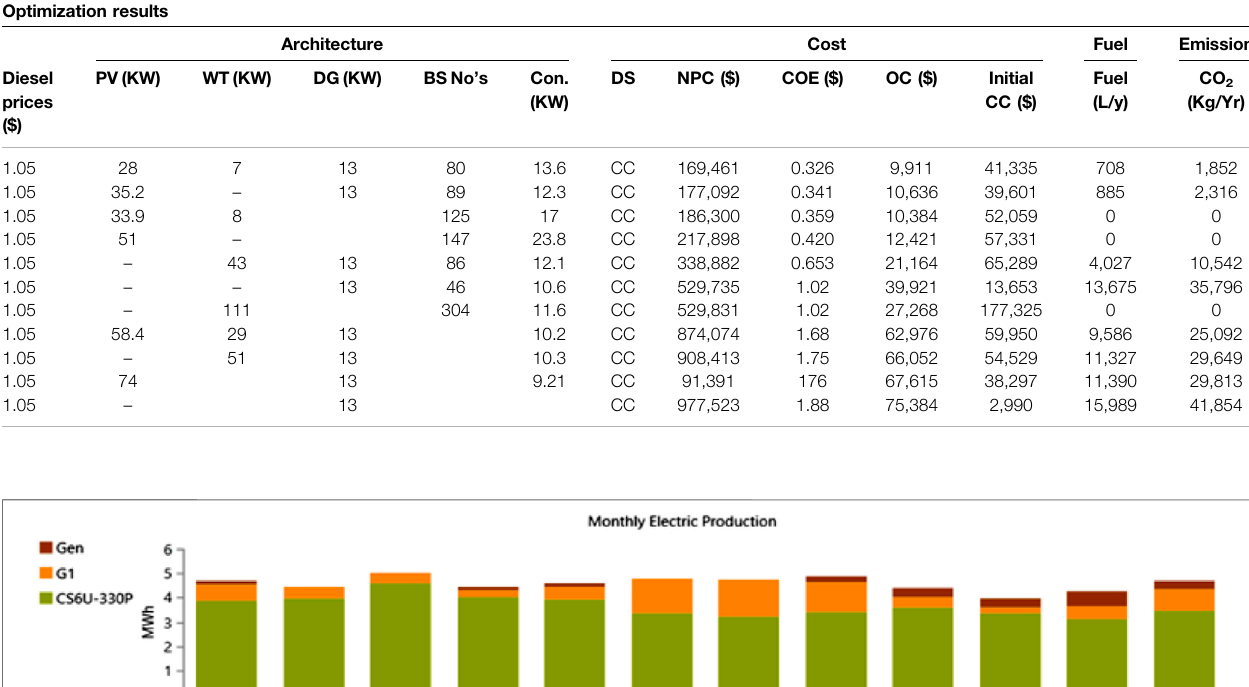
TABLE 8 | HOMER optimization results of the PV/Wind/Diesel/Battery system for the location Salem. Optimization results